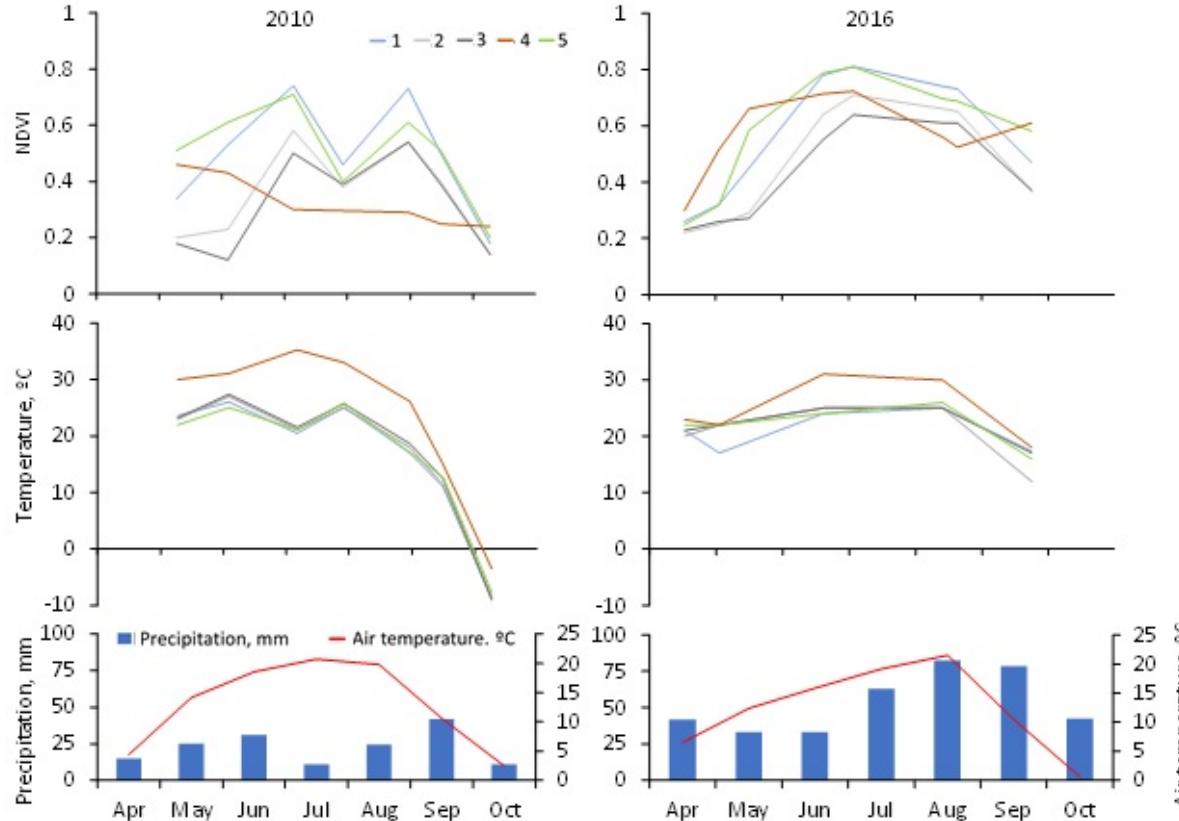
Figure 3. Seasonal changes of NDVI (top) and surface temperatures (middle) derived from Landsat earth observation data, in different habitats on the Arkaulovskoye Mire (1: sedge - reed birch forested mire; 2: sparse pine and birch forested mire; 3: Schoenus ferrugineus - small sedges - brown mosses open mire) and surrounding mineral land (4: pasture; 5: birch forest) during the 2010 (left) and 2016 (right) growing seasons. The bottom two graphics show monthly means of air temperature and precipitation at the Duvan weather station, approximately 35 km from Arkaulovskoye Mire, for the same